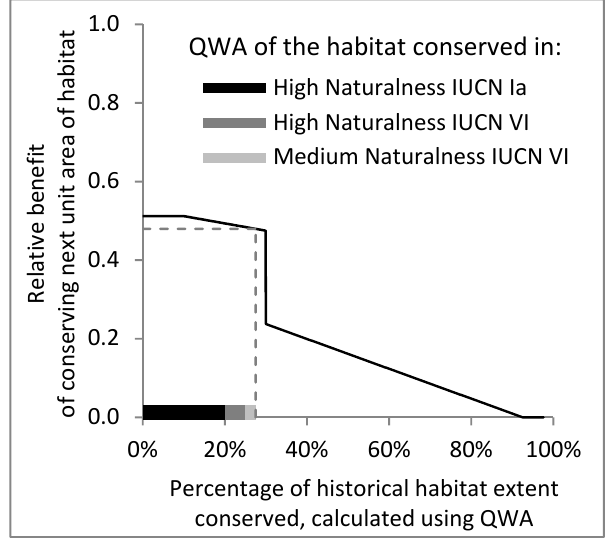
Figure 8. Using quality weighted area (QWA) to determine how much of a habitat is “conserved”. This is the example MVF for the boreal forest biome of Figure 7. In this hypothetical snapshot in time, 20% of its historical extent is conserved in each of the three condition/designation combinations. If the parameter values for medium naturalness value is 0.5, high naturalness is 1.0 (the max. value), IUCN VI land has a designation-weighted value of 0.25, and IUCN 1a land has a designation-weighted value of 1.0 (the max. value) then the QWA conserved of the above scenario is 27.5% of historical, translating to a relative benefit of 0.48 for conserving the next unit area of boreal forest. As more highly natural or medium-natural land gets conserved, in working landscapes or in re- serves, this value decreases accordingly.